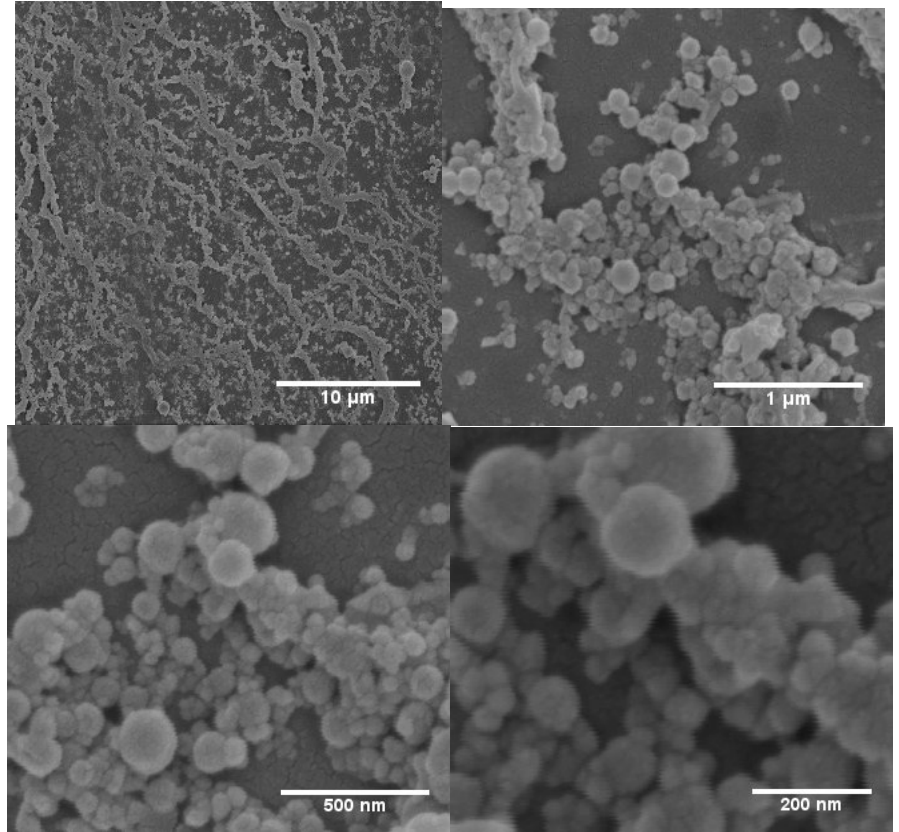
Figure 3. Particles prepared by spray-freezing, then dried at room temperature and neutral pH.